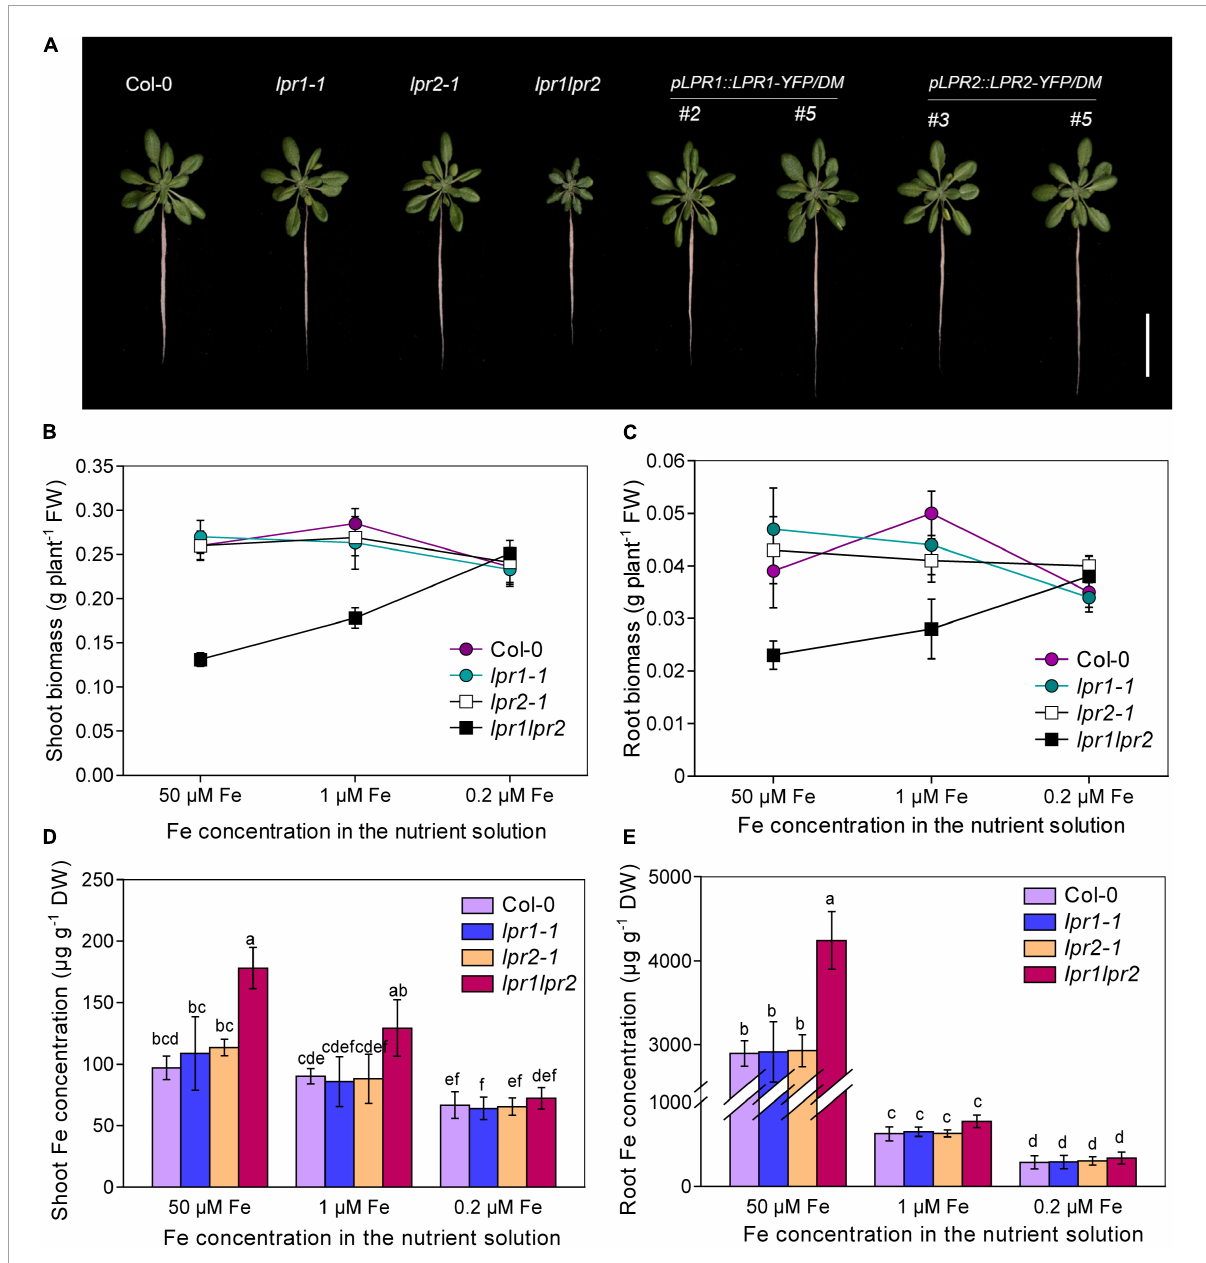
FIGURE1 LPRs are required for maintaining healthy Fe status. (A) Growth of Col-0, lpr1-1 , lpr2-1 , lpr1lpr2 , and complementation lines ( pLPR1:LPR1-YFP/DM #2 and #5; pLPR2:LPR2-YFP/DM #3 and #5) in Fe-sufficient (50 µ M) nutrient solution. DM, lpr1lpr2 double mutant. (B,C) Comparison of shoot fresh biomass and root fresh biomass between Col-0 and lpr1lpr2 grown under different doses of Fe. (D,E) The shoot and root Fe concentrations of the plants grown with different doses of Fe. The plants were precultured in low-Fe (0.2 µ M) nutrient solution for 3 weeks and transferred to the nutrient solution with different doses of Fe. Plants were photographed and harvested after treating for 7 days. Values are means ± SD of five replicates. Different letters represent a significant difference at P < 0.05 by Tukey’s test. Scale bars 4